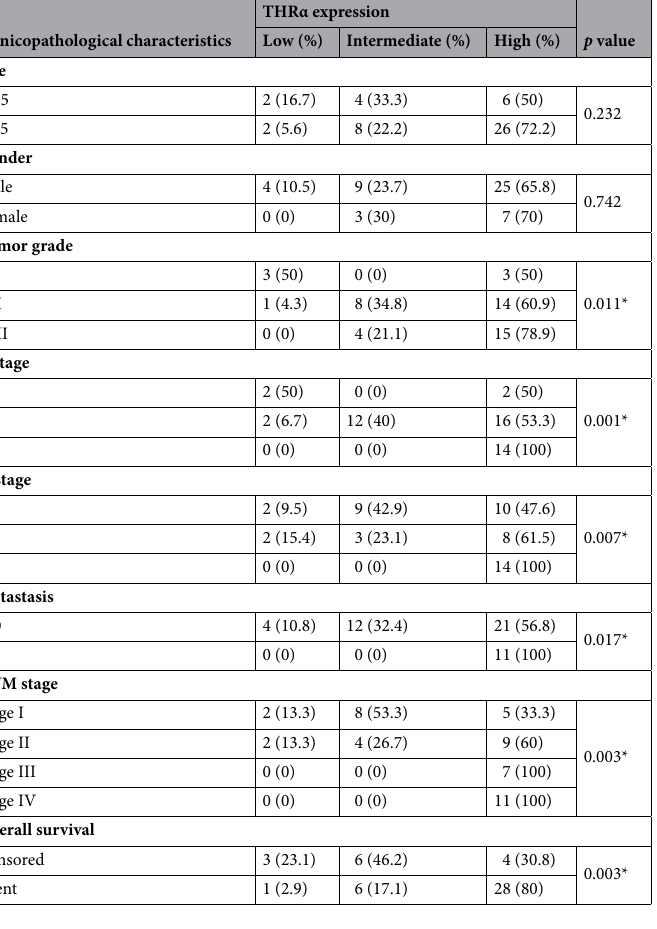
Table 2. The association between THRα1 expression and clinicopathological characteristics of NSCLC (SCC) cases (No = 48). Test of significance: Chi-square and Fisher exact tests. p -value < 0.05 is considered